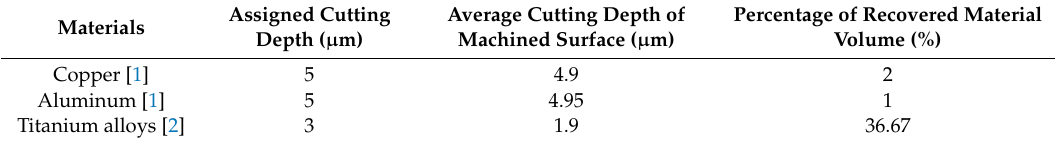
Table 1. The comparison of the level of material swelling of di ff erent materials and titanium